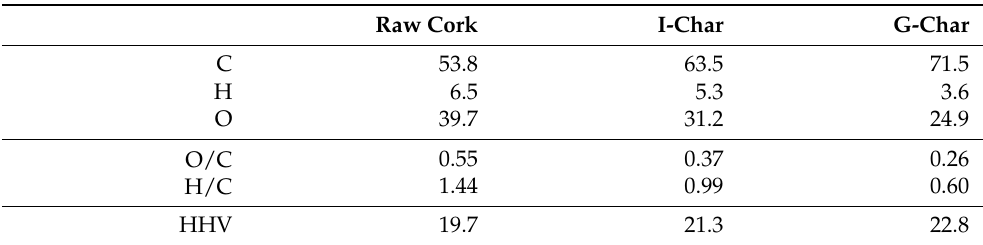
Table 2. Results of elemental analysis (%, ash-free basis), H/C and O/C atomic ratios, and higher heating values (HHV, MJ kg −1 ).